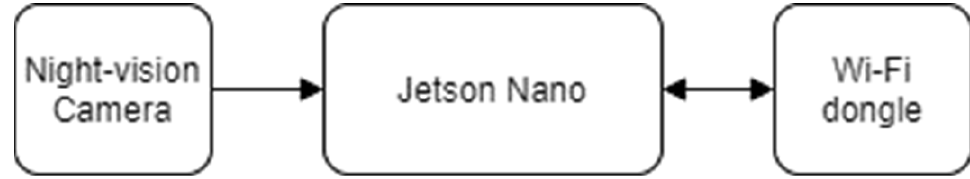
Figure 7. Block diagram of the baby monitor hardware.